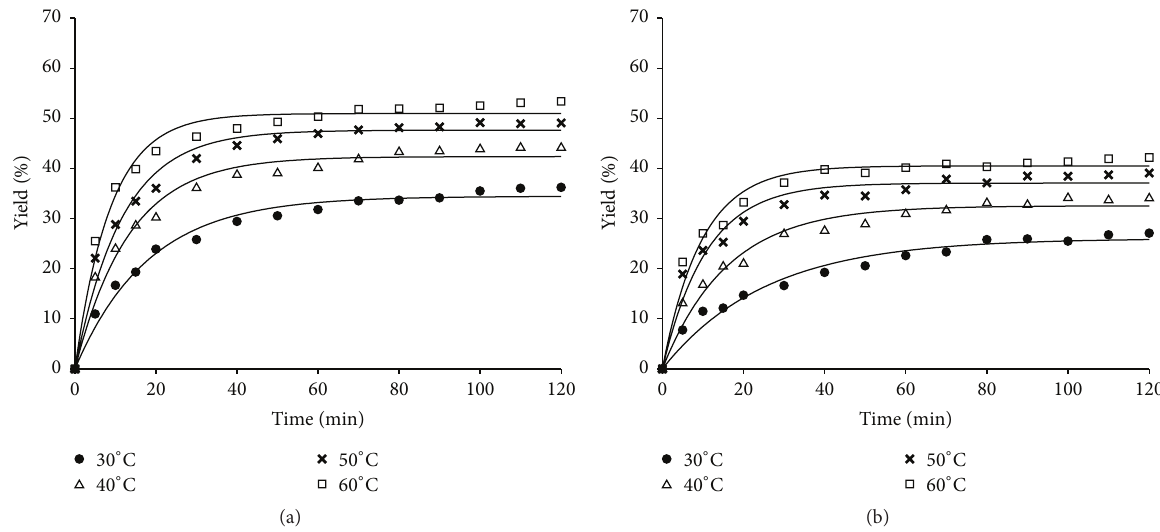
Figure 2: Kinetics of Jatropha oil extraction for an average particle size equal to 1.87 mm and moisture content of 0% (a) and 8.73% (b) at different